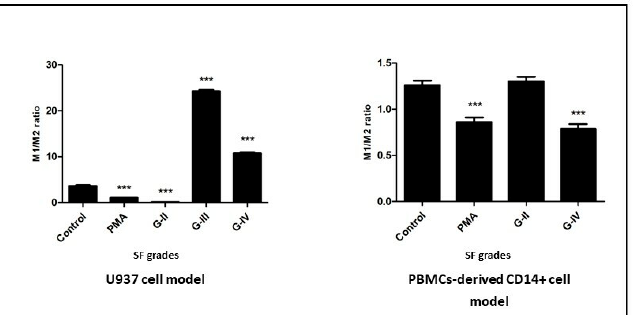
Figure 6. A grade-wise estimation of M1/M2 ratio in the newly differentiated cells after SF induction for 48 h in U937 and PBMC-derived CD14+ cells; in the assay on U937, the differentiation status was assessed using CD14, CD86, and CD163, while the assessment anti-body panel for PBMC-derived CD14+ cells included CD11C, CD86 (both M1 type), and CD163 (M2 type); M1/M2 ratio was estimated by dividing the average value of all M1 markers (U937—CD86 and PBMC-derived CD14 cells—CD11C + CD86) by the average value of the M2 marker (CD163) in each KL grade. * p < 0.05, ** p < 0.01, *** p < 0.001, as compared to control.